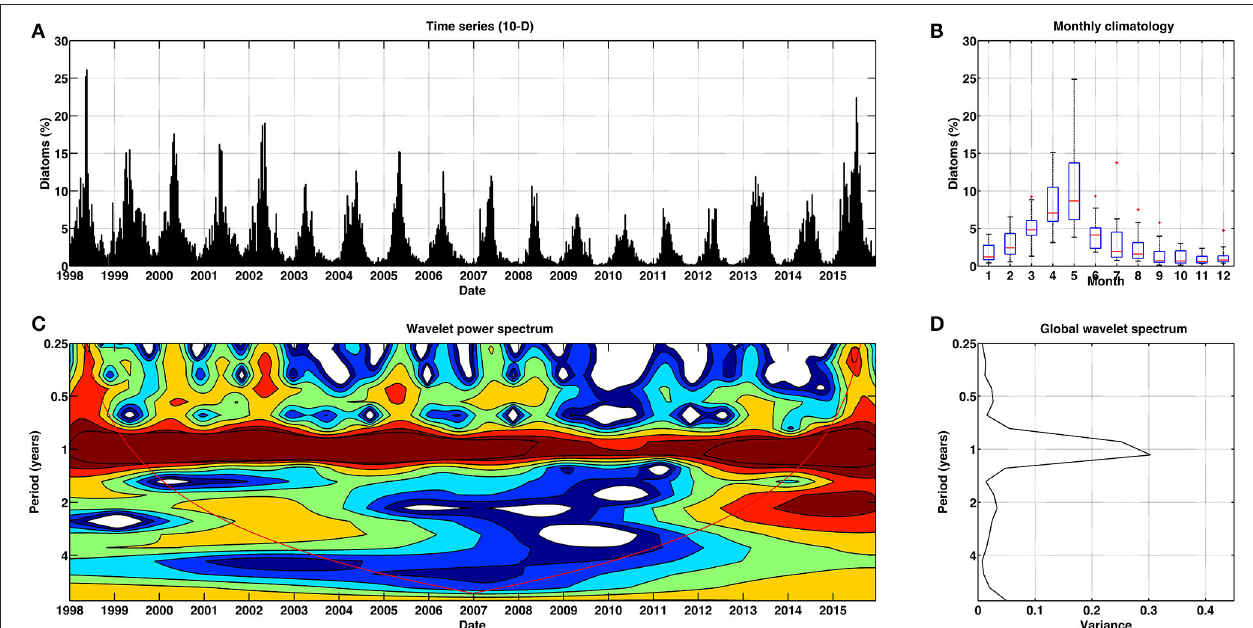
FIGURE 9 | Temporal patterns of variability for diatoms for Mediterranean Sea. (A) Temporal percentage (10-day) of diatoms. (B) Box plot (red lines stand for the median, blue box spans from the first to the second quartiles, and black lines represent 5th and 95th percentiles, respectively) of monthly climatology of diatoms. (C) Continuous wavelet power spectrum for the 10-day time series. Red line indicates the cone of influence, and is the region affected by the edges of the data and should not be considered. (D) Global wavelet spectrum for the 10-day time